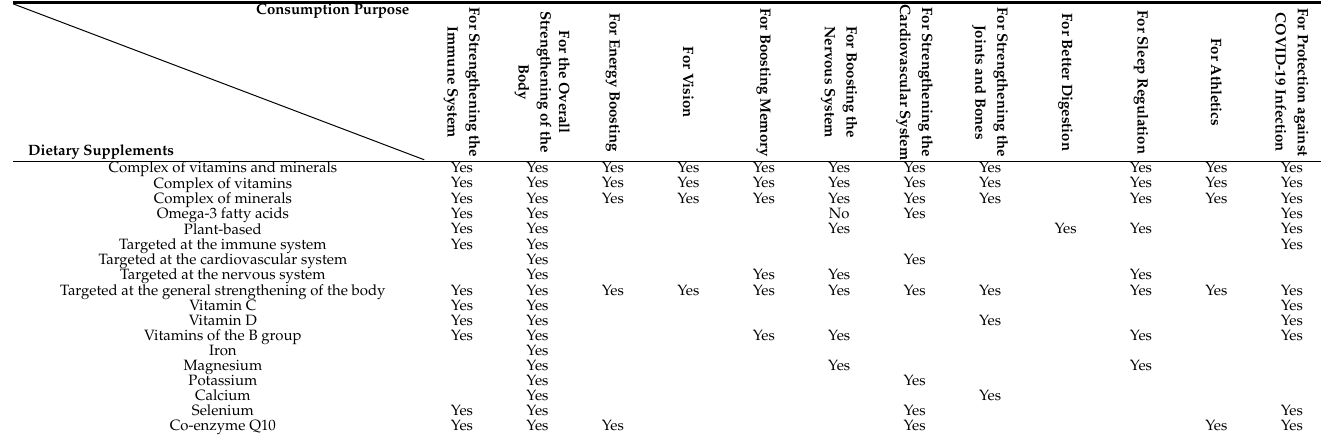
Table 3. Dietary supplements and the purpose of their consumption.